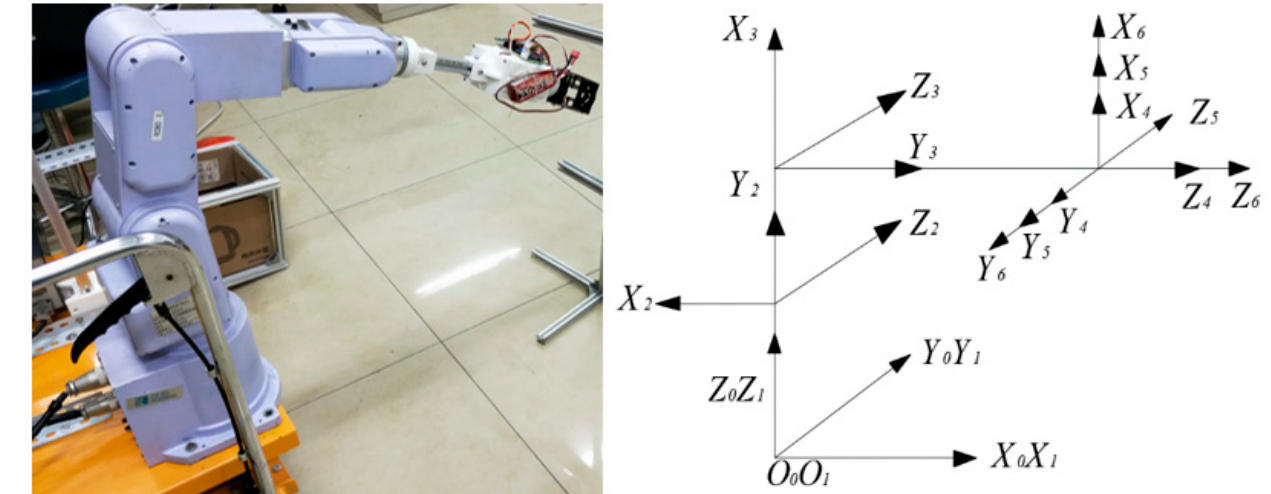
Figure 1. Picking manipulator and link coordinates system of the manipulator.